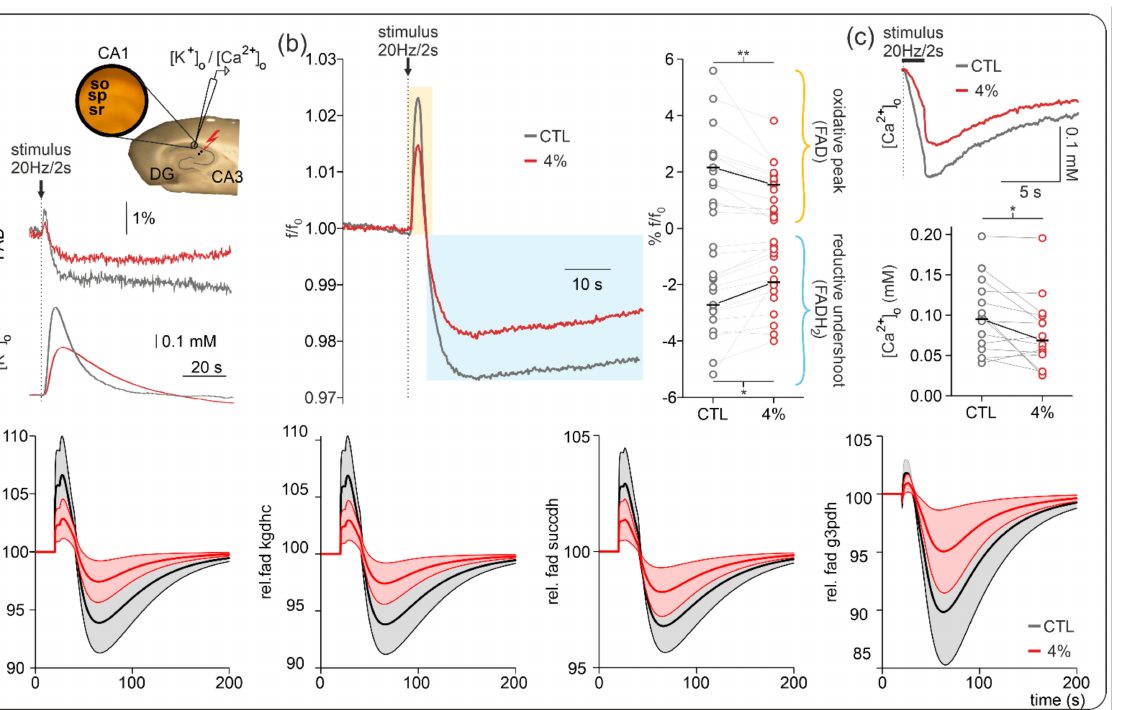
Figure 4. Effects of sevoflurane on flavin adenine dinucleotides (FAD). ( a ) Simultaneous recordings of stimulus-induced changes in FAD autofluorescence and [K + ] o or [Ca 2+ ] o were performed in area CA1 as represented along with example traces of FAD/[K + ] o in control (black) and under 4% sevoflurane (red). Note that the decrease in FAD peak and undershoot correlated with decreased [K + ] o rises as tissue excitability decreases as well. ( b ) Left: Averaged stimulus-induced FAD transients in control (black trace) and under 4% sevoflurane (red trace). Stimulus-induced FAD signals typically have two components: a first oxidative peak immediately after stimulation followed by a reductive undershoot. In the presence of 4% sevoflurane, both components diminished as synaptic activity decreased. ( c ) Ca 2+ input onto neurons decreased under 4% sevoflurane, generating the boundary conditions for an activity-dependent reduction in oxidative metabolism. Statistical comparison: repeated measures ANOVA. After Bonferroni correction significance given with * = p < 0.05, ** = p < 0.01. ( d ) Modeling of relative changes in FAD signaling during electrical stimulation without sevoflurane (black) and with 4% isoflurane (red) for the pyruvate dehydrogenase (pdhc), α -ketoglutarate dehydrogenase (kgdhc), succinate dehydrogenase (succdh), and mitochondrial glycerol-3-phosphate dehydrogenase (g3pdh). The solid line and shaded area depict the mean and SD of simulated FAD signals for the individual